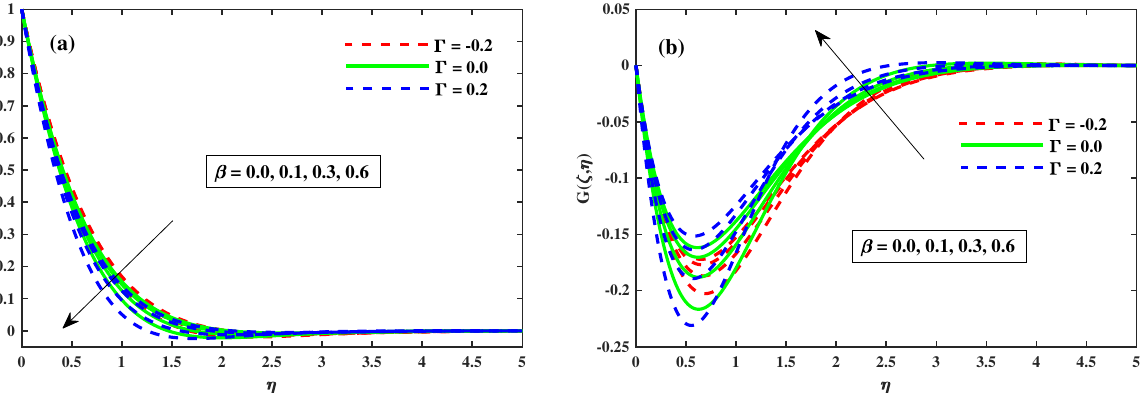
Figure 5. Influence of β on G along y-direction in ( b ) and F (cid:48) along x-direction in ( a ) when ζ = 1. Figure 6a,b shows the graphics of C f √ C f Re x (axial direction) closer to the surface for the ζ ( 0 : 0.2 : 1 ) spectrum and for y M ( 1 : 1 : 5 ) . As shown in Figure 6a, increasing ζ ( 0 → 1 ) gradually increases the spread √ Re x ) until no significant difference is observed. In contrast, the ( C f of ( C f x adjacent to the plate substrate decreases significantly when M is